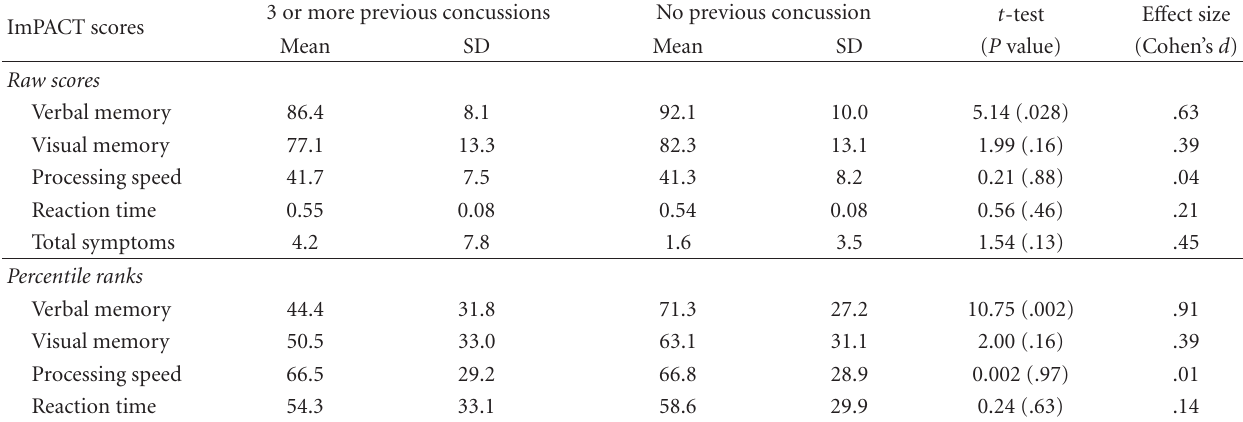
Table 1: Performance on ImPACT in athletes with 3 or more previous concussions and matched